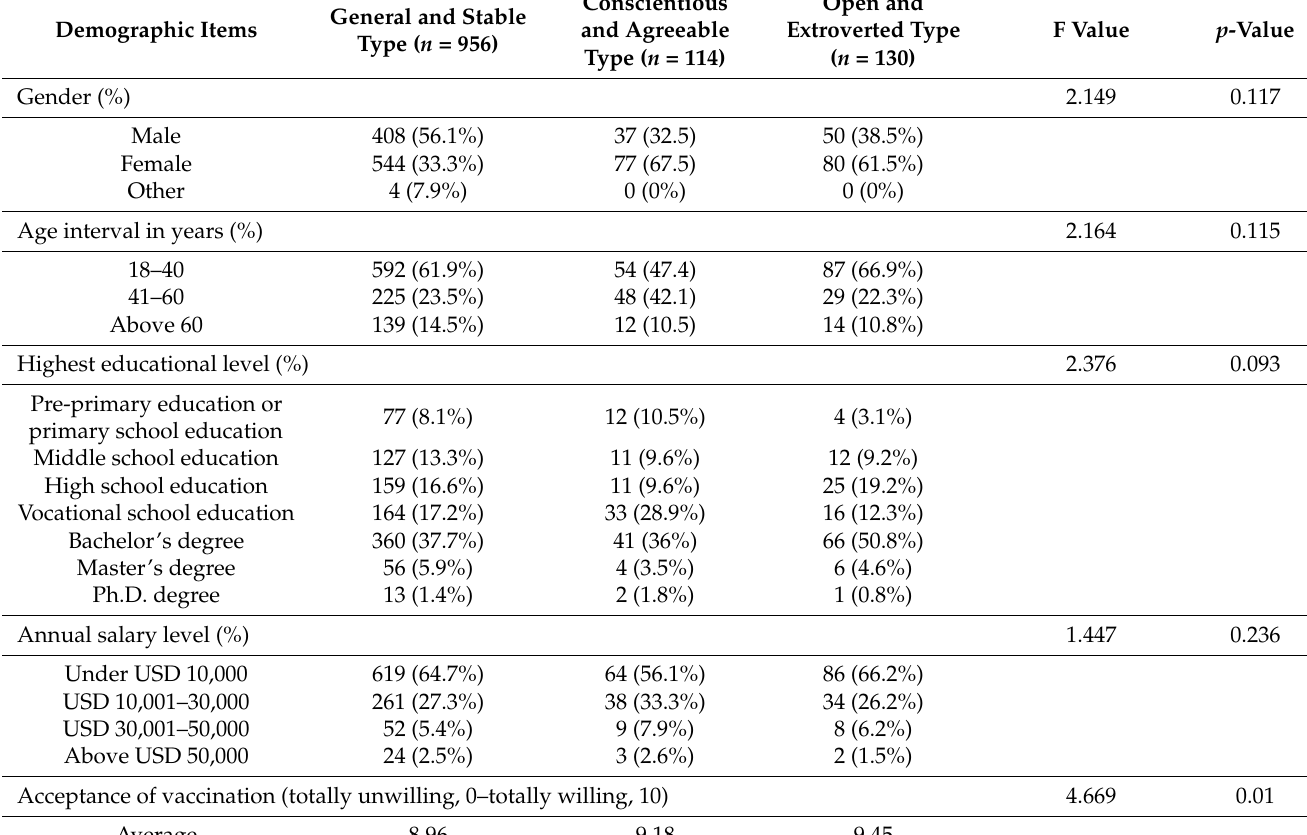
Table 4. Demographic characteristics of different personality